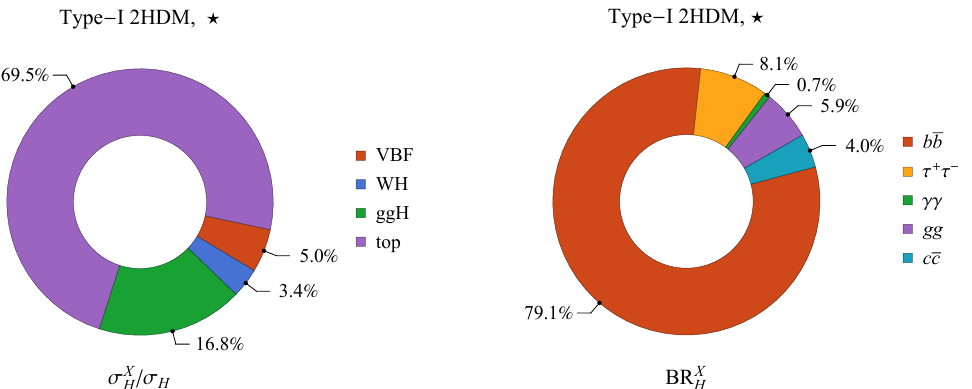
Figure 7 . As (cid:12)gure 3 but for the second type-I 2HDM benchmark scenario (3.2). The label \top" in the left panel refers to H production via the cascade top-quark pair or single-top events. With the exception of BR (cid:13)(cid:13) larger than 3% are